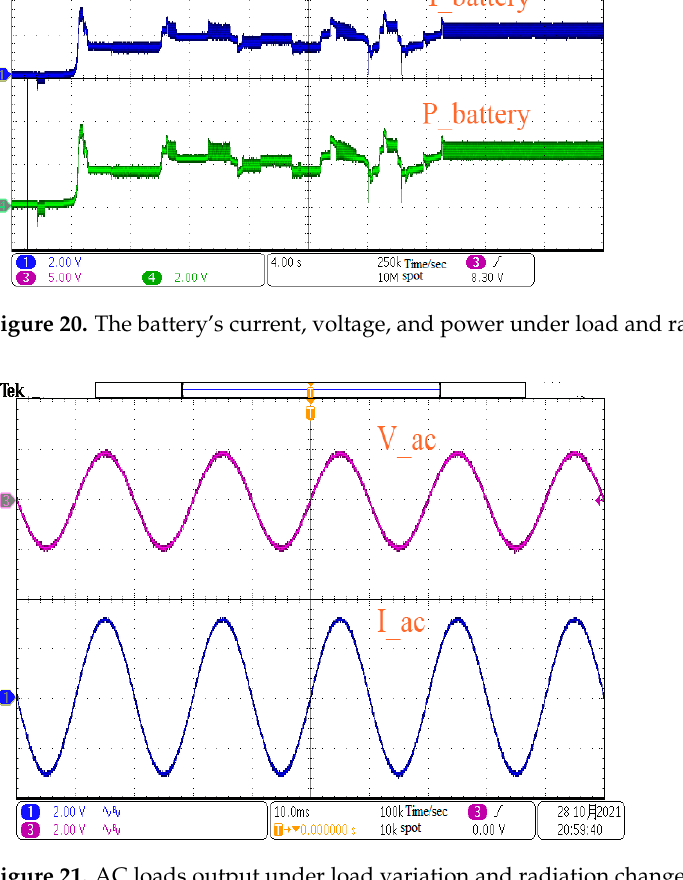
Figure 21. AC loads output under load variation and radiation changes; ( 月 is month).